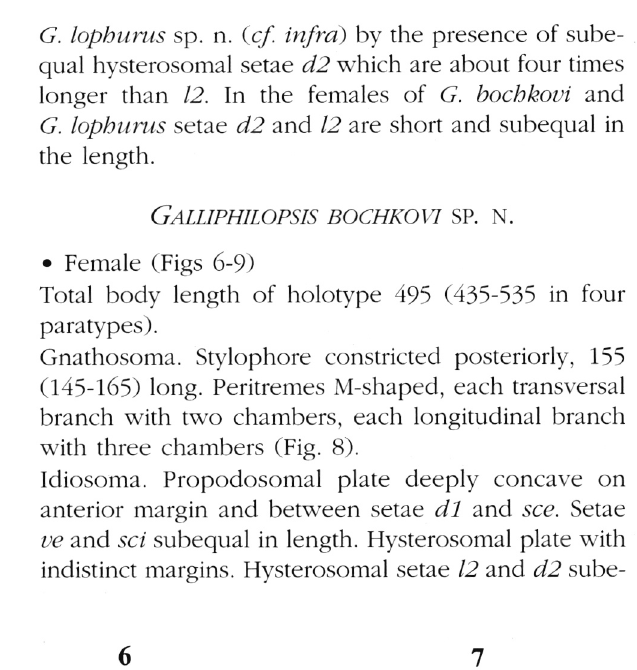
Figs 6-9. - Galliphilopsis bochkovi sp. n. Female, 6. Dorsal view. 7. Ventral view. 8. Peritremes. 9. Fan seta p